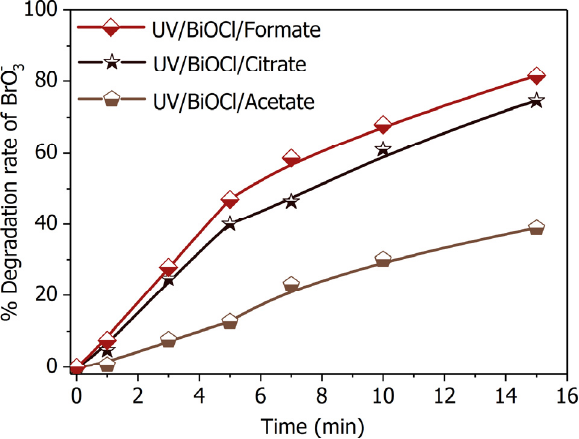
Figure 9. Bromate degradation efficiency by in presence of different SOCA. Conditions: [Formate] 0 = [Citrate] 0 = [Acetate] 0 = 4 mM; BiOCl-HAP SM dosage 0.5 g·L − 1 , [ BrO (cid:2871)(cid:2879) ] 0 = 6.6 μ M, pH = 7.0 ± 0.1, 25 °C, reaction time 15 min.